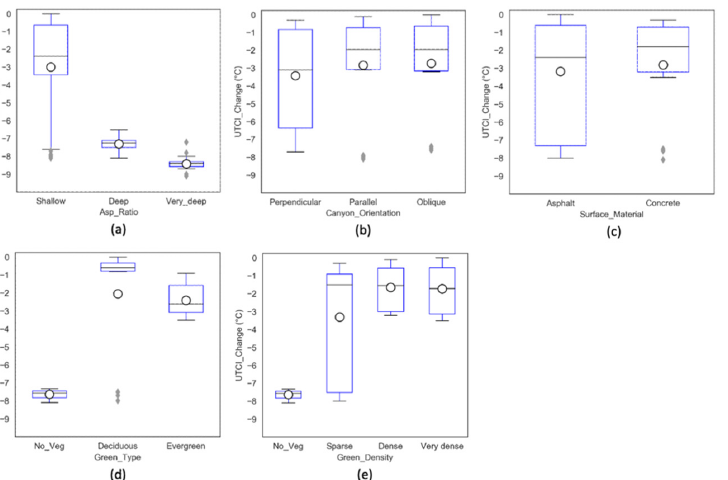
Figure 3. Sensitivity of UTCI to different physical and vegetation parameters (at 15:00). ( a ) shows the UTCI level change in different canyon depths among all scenarios, while ( b – e ) presents the results for the shallow canyon types. The horizontal lines reflect the minimum, first, second (median), third quartile, and maximum of data points. Circles represent the average of UTCI level change in each category.